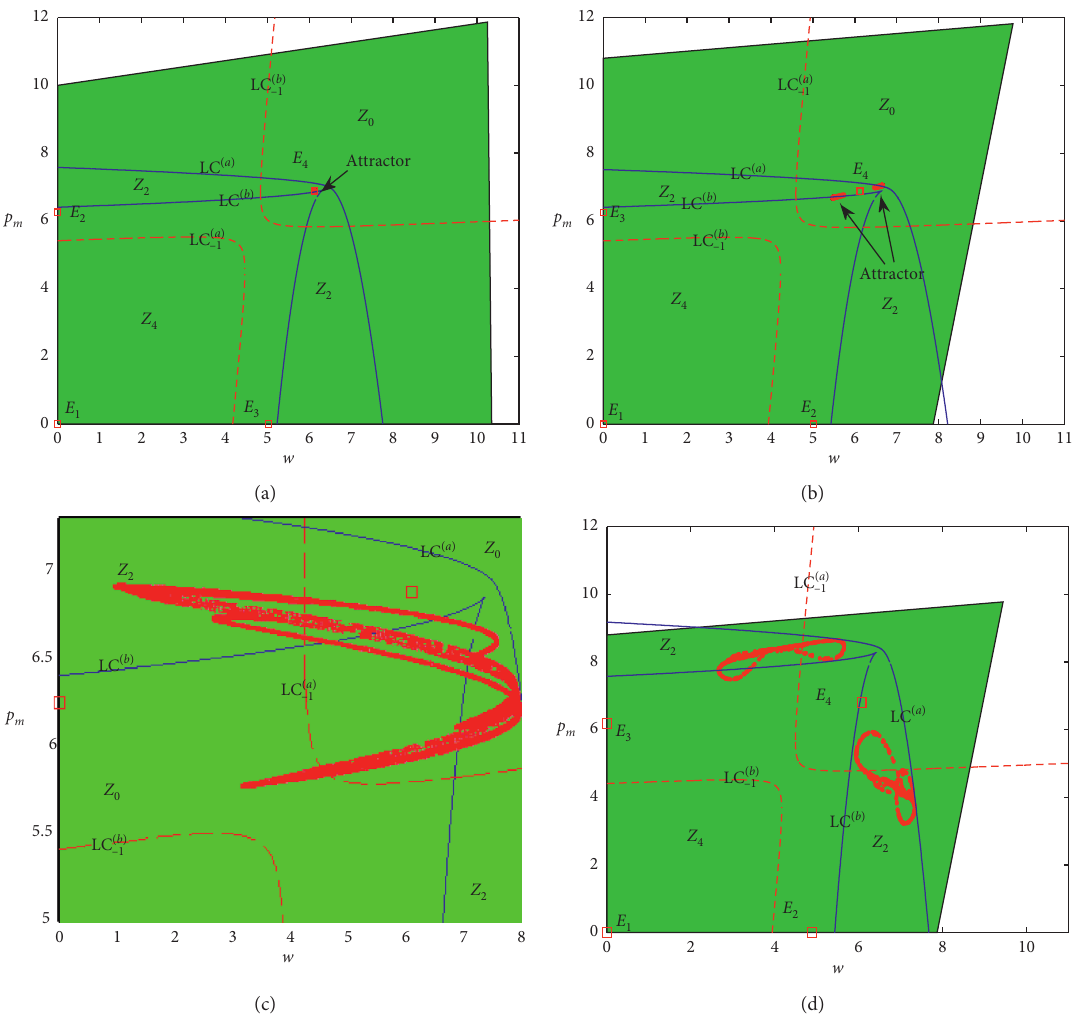
Figure 6: Attractors (red dot) and basins of attractors (green region) where LC a and LC b are represented by blue solid line, and LC a are represented by red dotted line when δ � 0 . 2 . These curves of LC separate the plane into three regions, denoted by Z LC b − 1 whose points have four, two, and no rank-1 preimages, respectively. (a) κ w � 0 . 3 , κ p � 0 . 14 , τ � − 0 . 2. (b) κ w � 0 . 35 , κ p � 0 . 14 , τ � − 0 .